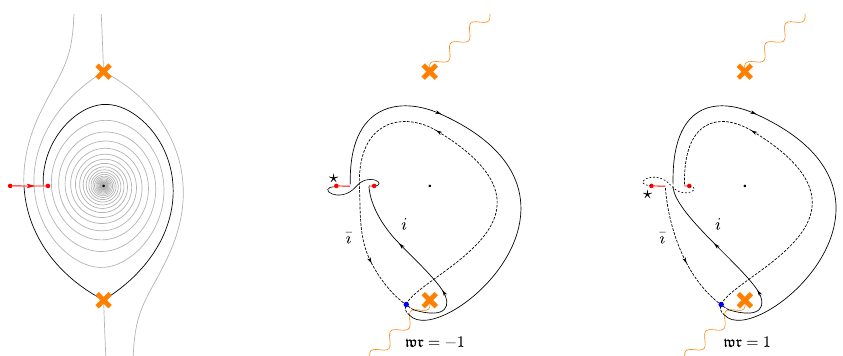
Figure 8. 2d BPS particles arising as concatenations of (cid:22) {i and i (cid:22) { 2d-4d solitons. The self- intersection of the path comes from a single point (the blue dot), and its sign depends on